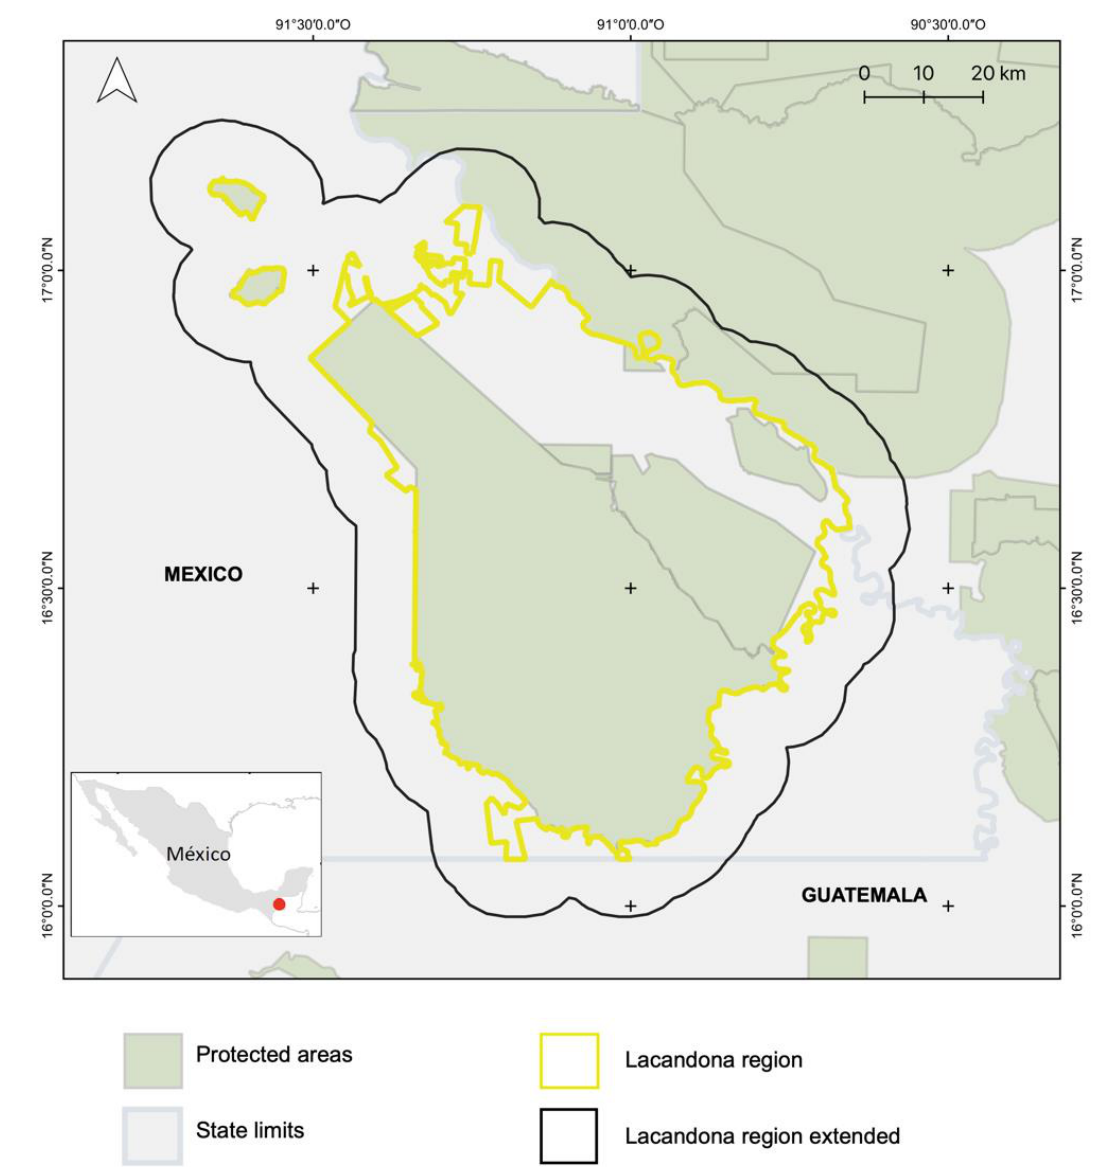
Figure 1. Location of the Lacandona and extended Lacandona regions in southern Mexico. Green polygons are protected areas; thick lines are limits of the State of Chiapas; yellow line depicts the Lacandona region; black line depicts the extended Lacandona region. Red dot represents the study area.